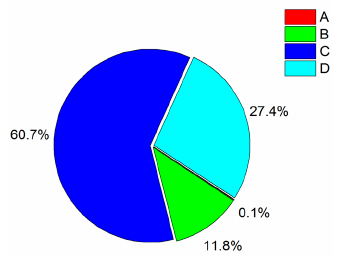
Figure 18. Total variation analysis map.